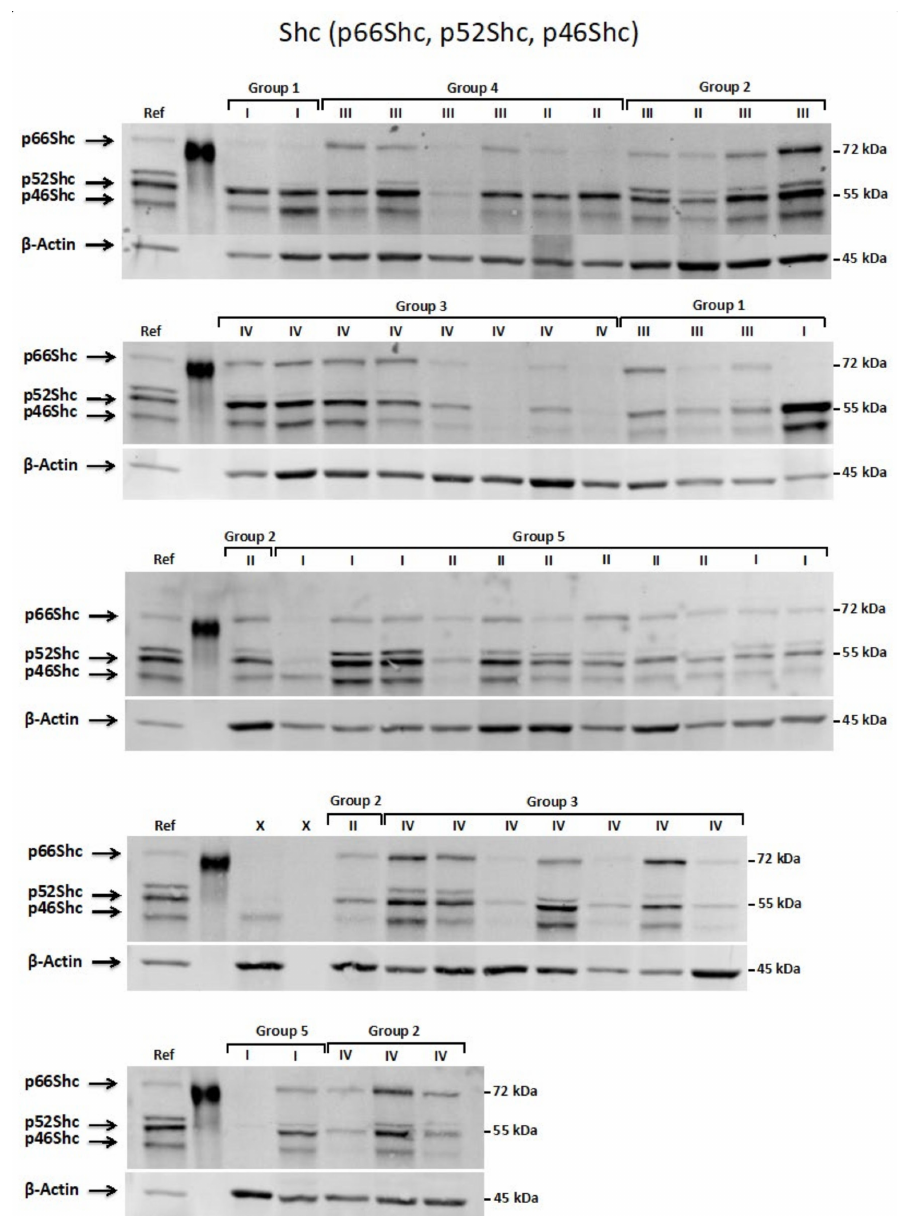
Figure 6. Western blot analysis of ShcA isoform levels in investigated pediatric brain tumors. The figure shows representative image of p66Shc, p52Shc, and p46Shc levels. The assignment to the tumor type and tumor grade is shown above the individual samples. Group 1—choroid plexus tumors; Group 2—diffuse astrocytic and oligodendroglial tumors; Group 3—embryonal tumors; Group 4—ependymal tumors; Group 5—other astrocytic tumors. Roman numerals (I, II, III, and IV) represent the grade of malignancy based on the WHO grade, representing the severity and prognosis of the condition. Reference sample (Ref). The level of p66Shc, p52Shc, and p46Shc was assessed immunochemically with the use of specific antibodies and subjected to the statistical analysis described in the Materials and Methods